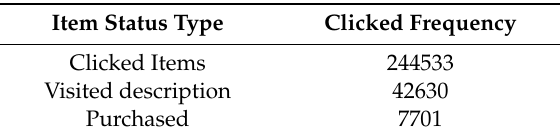
Table 5. Item status type vs click